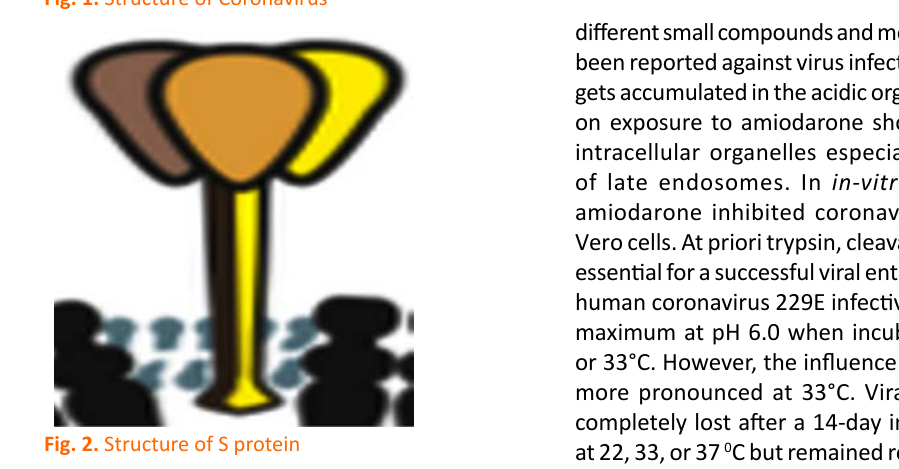
Fig. 1. Structure of Coronavirus